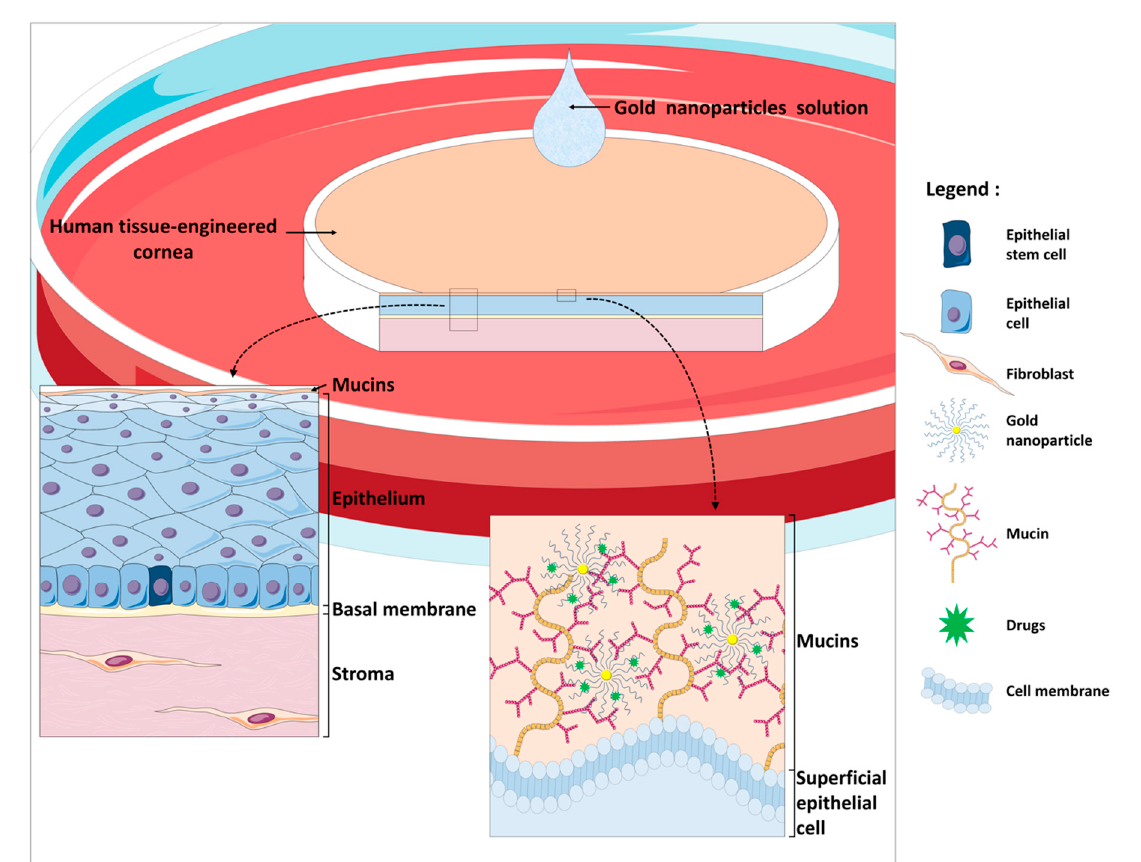
Figure 8. The hTEC as a model for the development of a gold nanoparticle drug delivery system. Illustration of the use of the hTEC as a platform for the development of drug delivery systems. Left insert: layers composing the hTEC (stroma, basal membrane, epithelium, and mucins) for the assessment of drug absorption, controlled release of drugs, permeation studies, bio-distribution, cytotoxic assays, efficacy assays, and pharmacokinetic studies. Right insert: Mucosal layer in the tear film, composed of mucins that can interact with mucoadhesive molecules such as the gold nanoparticles, as shown here.